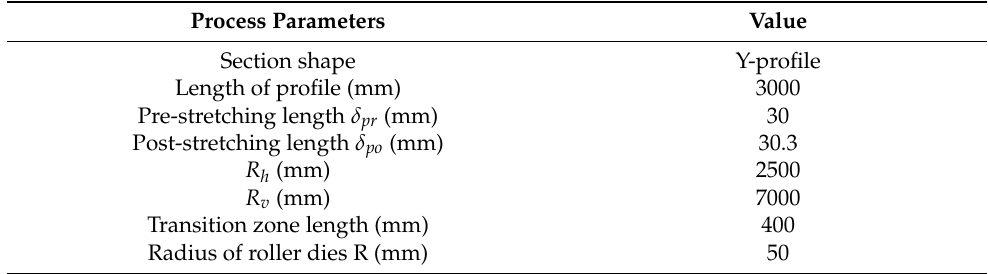
Table 3. Experimental process parameters.